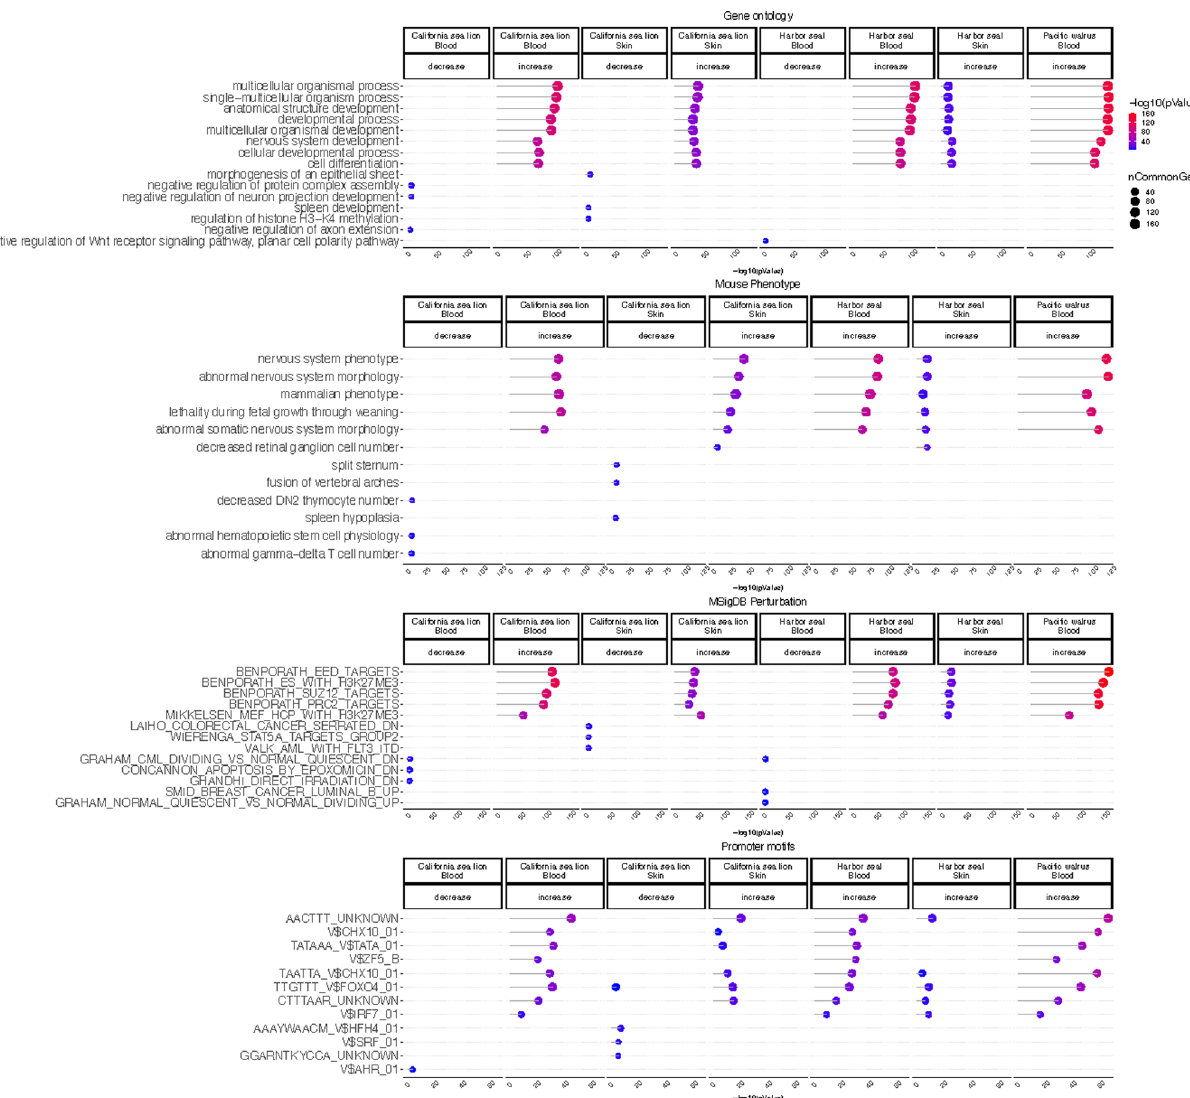
Fig. 5 Gene set enrichment analysis of age-related CpGs in pinniped tissues. The gene level enrichment was done using GREAT analysis 69 and human Hg19 background limited to CpGs that could be aligned to three pinniped species. The CpGs were annotated with adjacent genes in a 50 kb fl anking region. We extracted up to 500 of the top CpGs based on p < 0.005 of association per direction of change as input for the enrichment analysis. The p values were calculated by hypergeometric test of the epigenome-wide association study (EWAS) results with the genes in each background dataset. Datasets: gene ontology; mouse phenotypes; promoter motifs; and MsigDB Perturbation, which includes the expression signatures of genetic perturbations curated in GSEA database. The results were fi ltered for signi fi cance at p < 10 − 5 , minimum overlap of 3 genes, and only the top terms for each EWAS